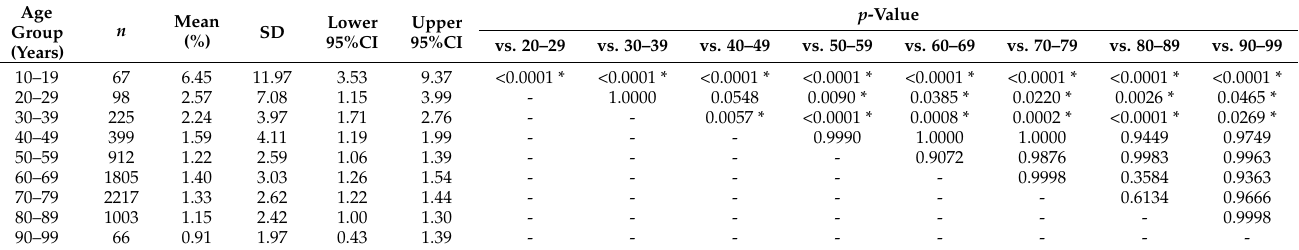
Table 5. FP stratified by age.